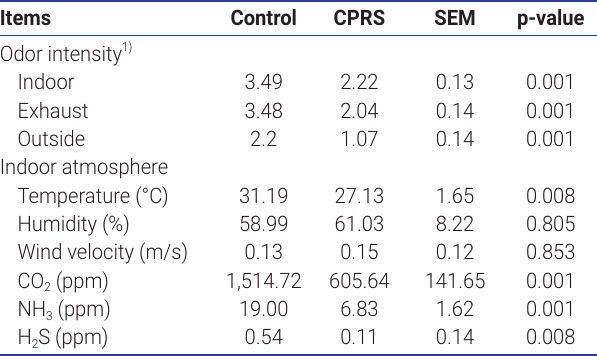
Table 4. Comparison of odor intensity and atmosphere characteris- tics in the finishing pig house according to the application of contin - uous pit recirculation system